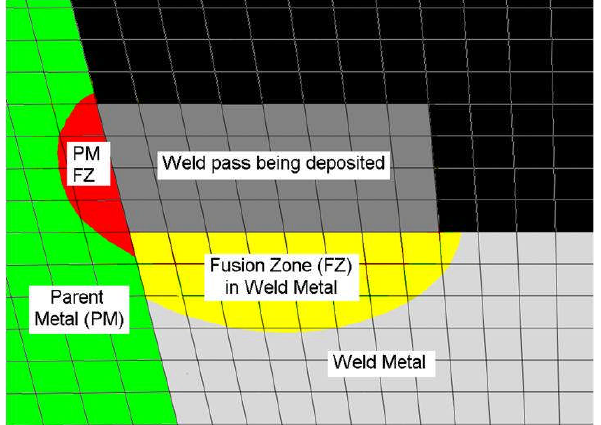
Figure 9. Fusion zones (FZ) when heat flux is applied to pipe and weld elements.